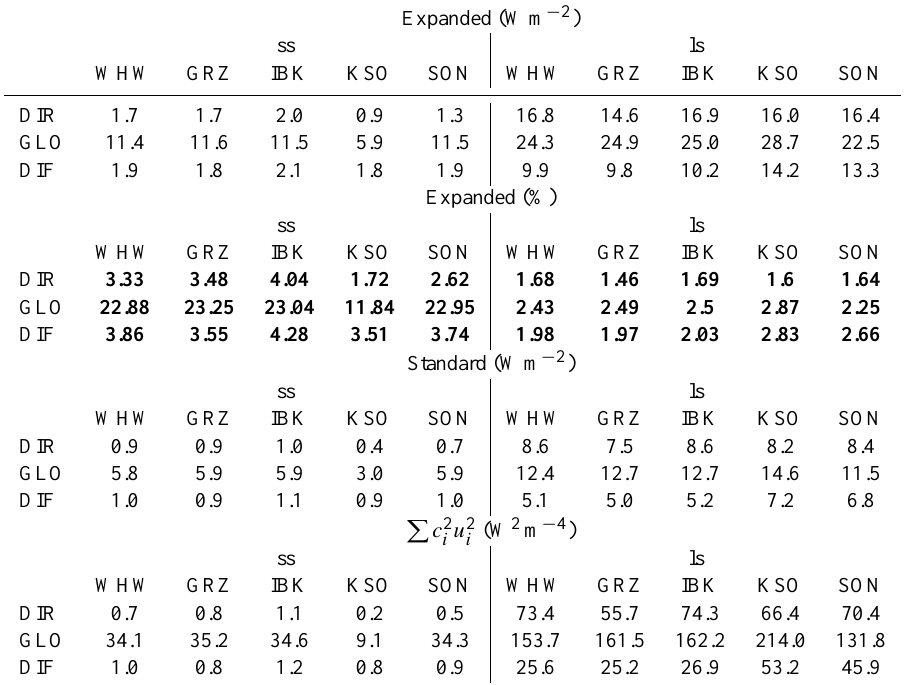
Table 7. Same as Tables 4–6, but combined uncertainties affecting shortwave measurements at all ARAD sites. Relative combined expanded values are marked in bold to allow the comparison with BSRN target accuracies (see Sect.